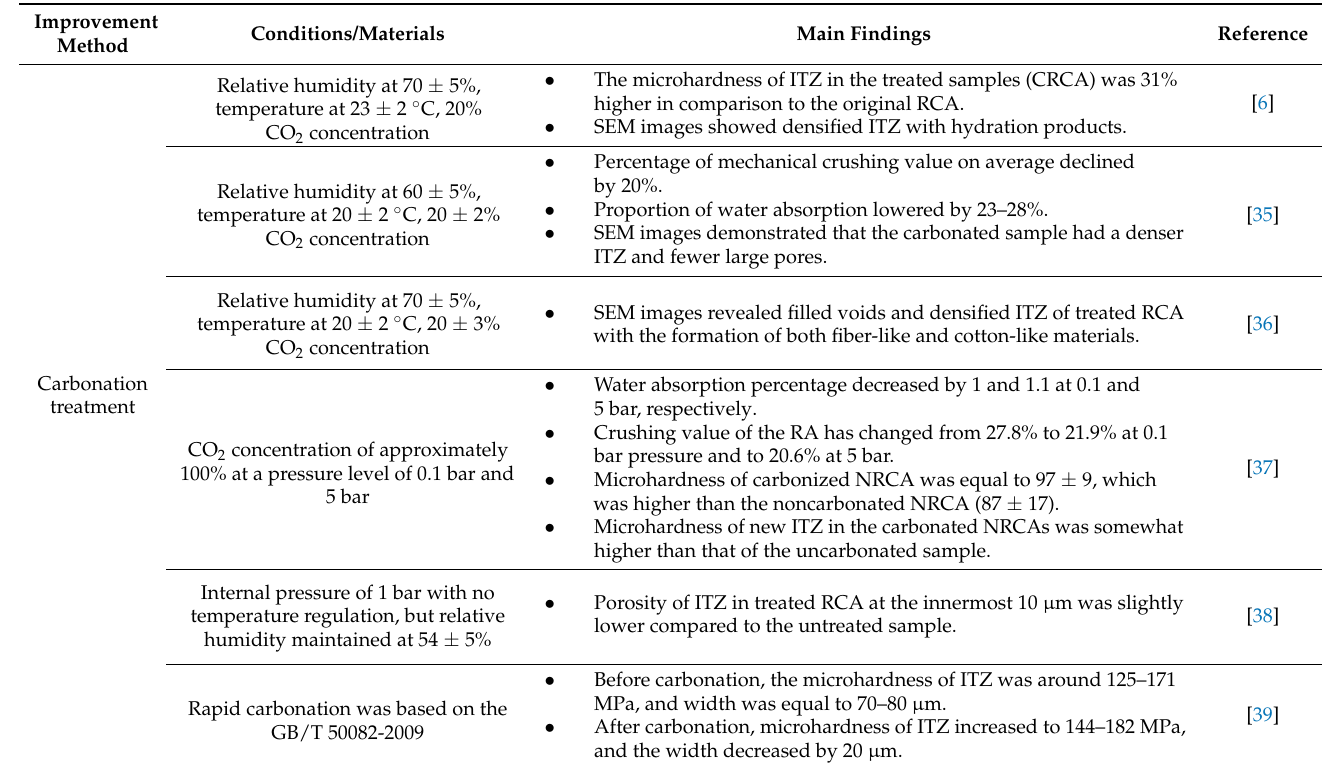
Table 5. Improvement methods for ITZ of